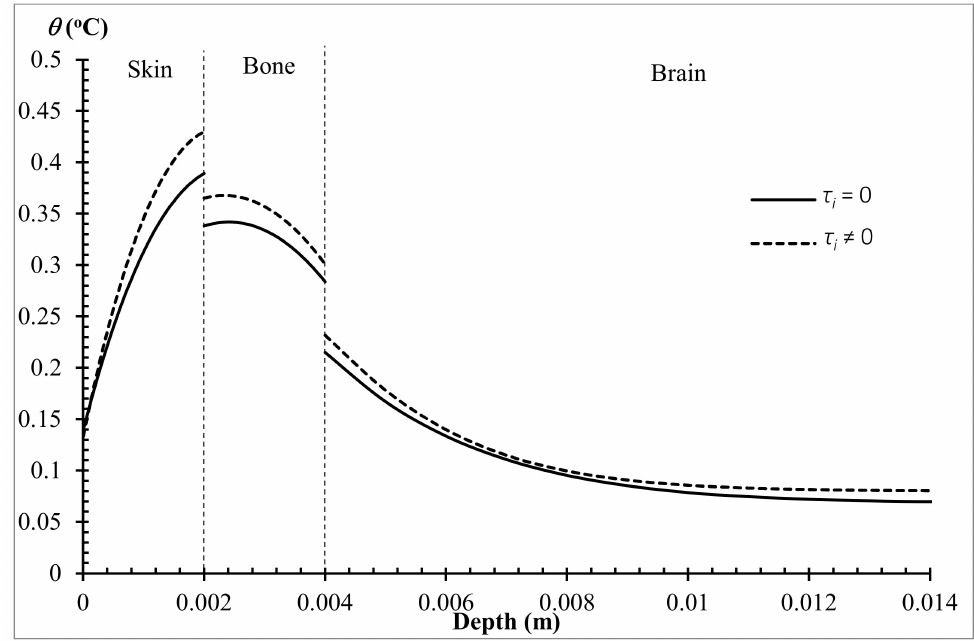
Figure 17. The dynamical temperature increment with various relaxation times on the child’s